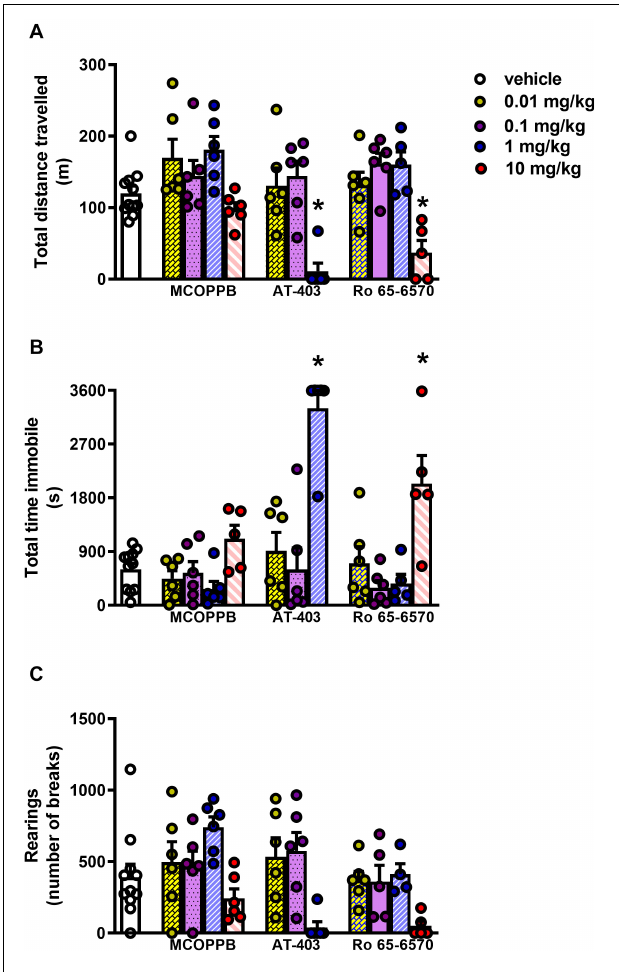
FIGURE 4 | Locomotor activity test in CD-1 mice, dose response curves to AT-403, MCOPPB, and Ro 65-6570 injected i.p. (A) cumulative distanced traveled in 60 min, (B) total time spent immobile in 60 min, (C) cumulative number of rearings performed in 60 min. Each point represents the mean ± sem of 6 mice/group. One-way ANOVA revealed an effect of NOP agonists in the total distance traveled F ( 11 , 63 ) = 8.00, immobility time F ( 11 , 63 ) = 13.53, and number of rearings F ( 11 , 63 ) = 3.76. * p < 0.05 vs. vehicle, Dunnett’s test.